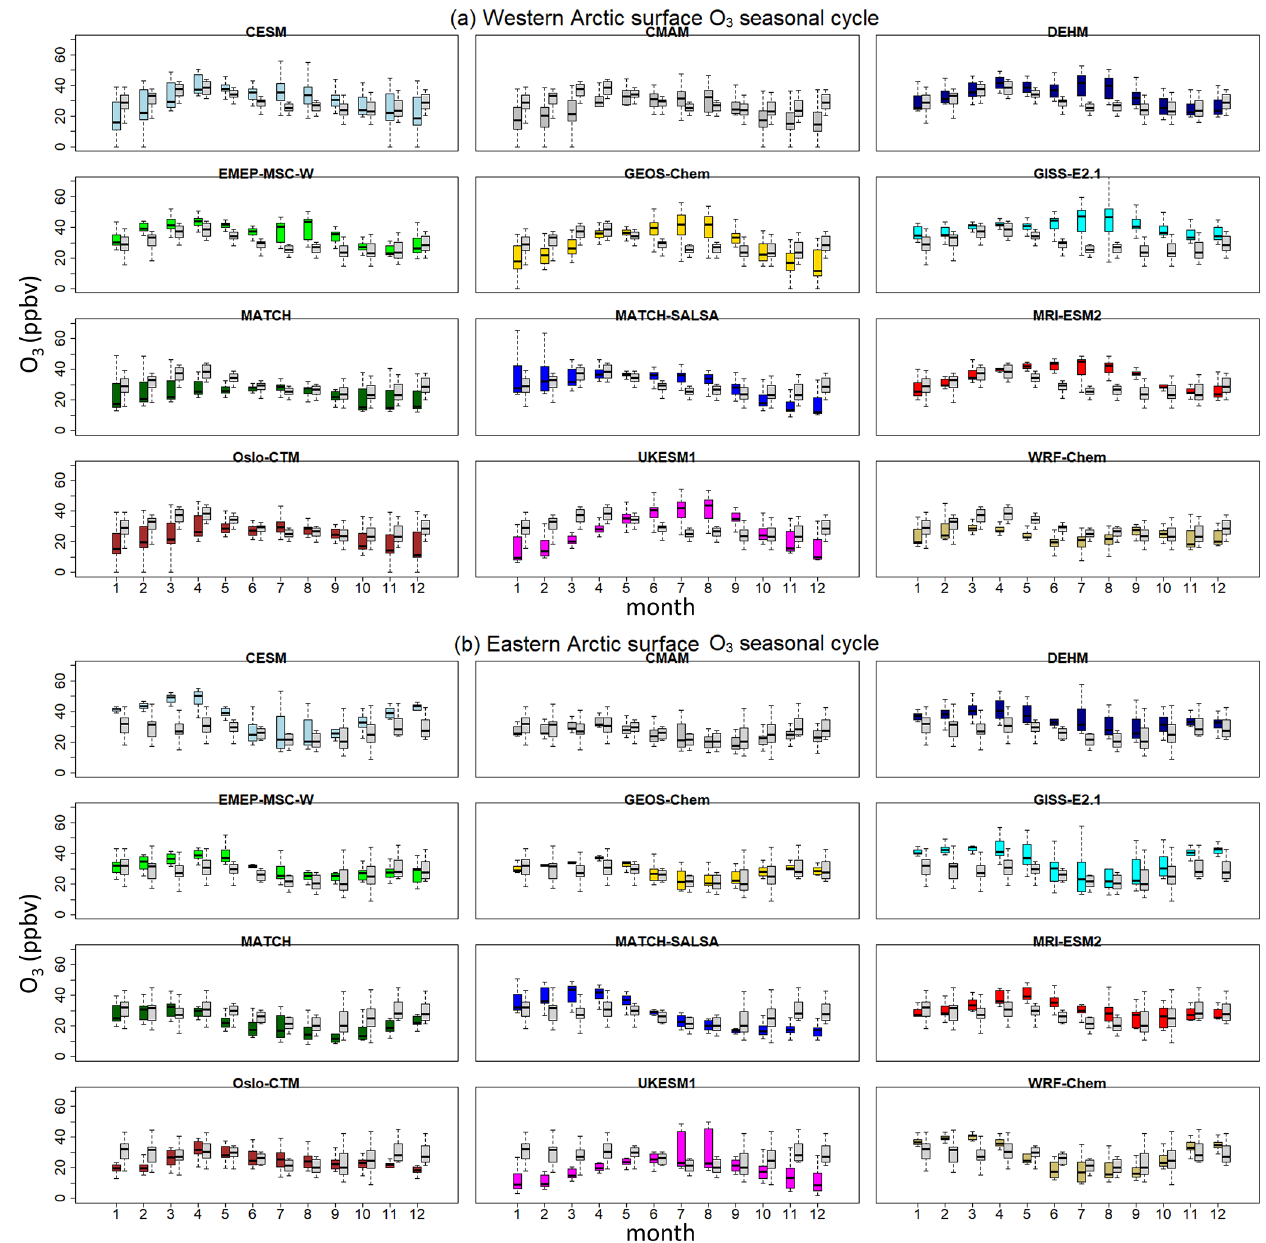
Figure 8. Surface O 3 monthly range that occurs at the locations in Fig. 7 above 60 ◦ N. The measurements are the black and white boxes and whiskers, and the models are the colored box and whiskers. (a) The western Arctic and (b) the eastern Arctic for 2014–2015. Thick horizontal lines indicate the median O 3 VMR in each month, and the box extends to the interquartile range. The whiskers extend to the minimum and maximum monthly mean O 3